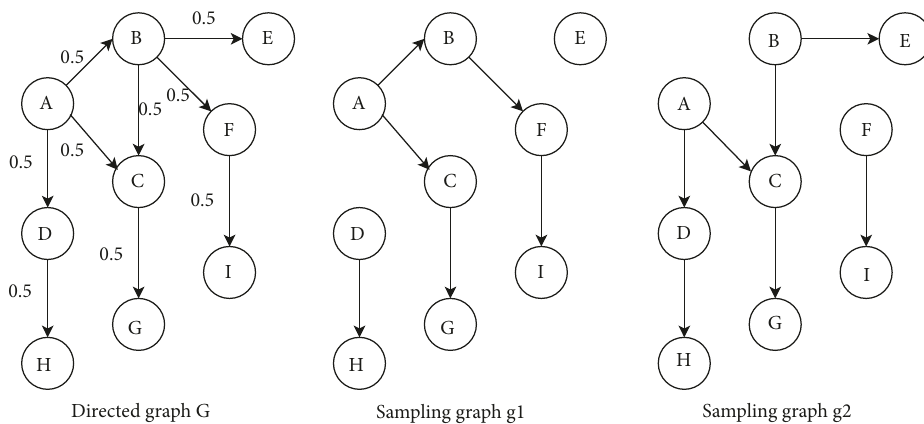
Figure 3: Sampling graph and reverse reachable set on blockchain social